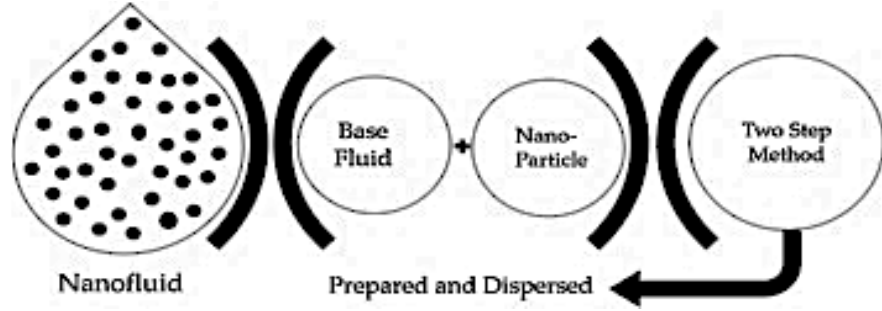
Figure 3. Portrayal of two-step method of nanofluid preparation [66].